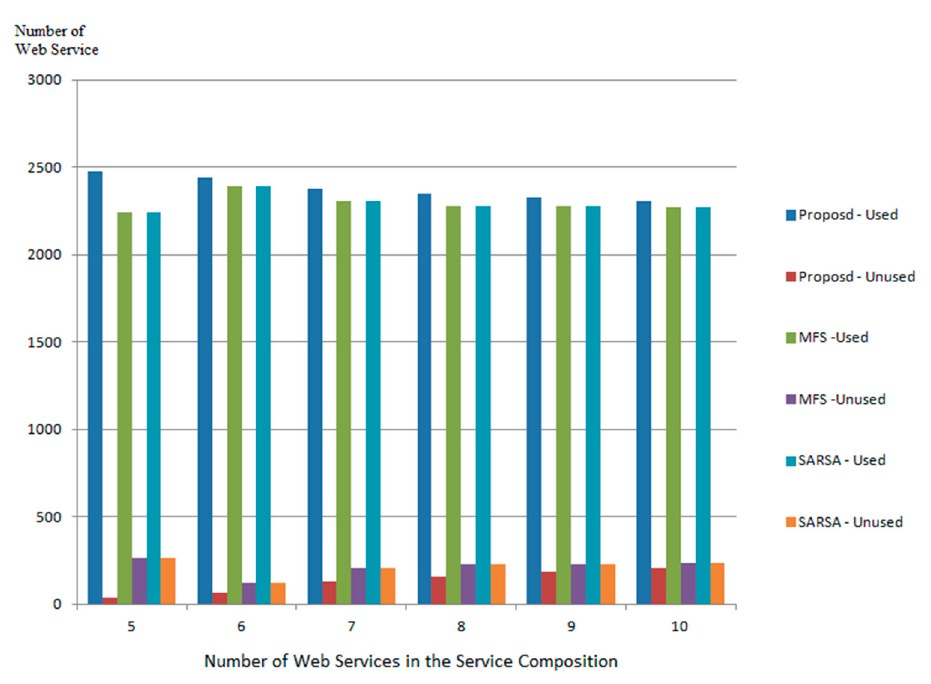
Figure 8. The number of used and unused web services when the composition threshold = 200.